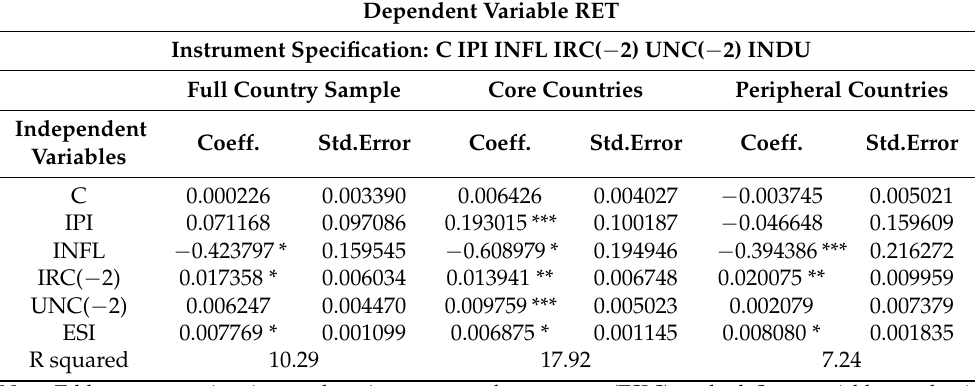
Table 6. Results using TSLS with